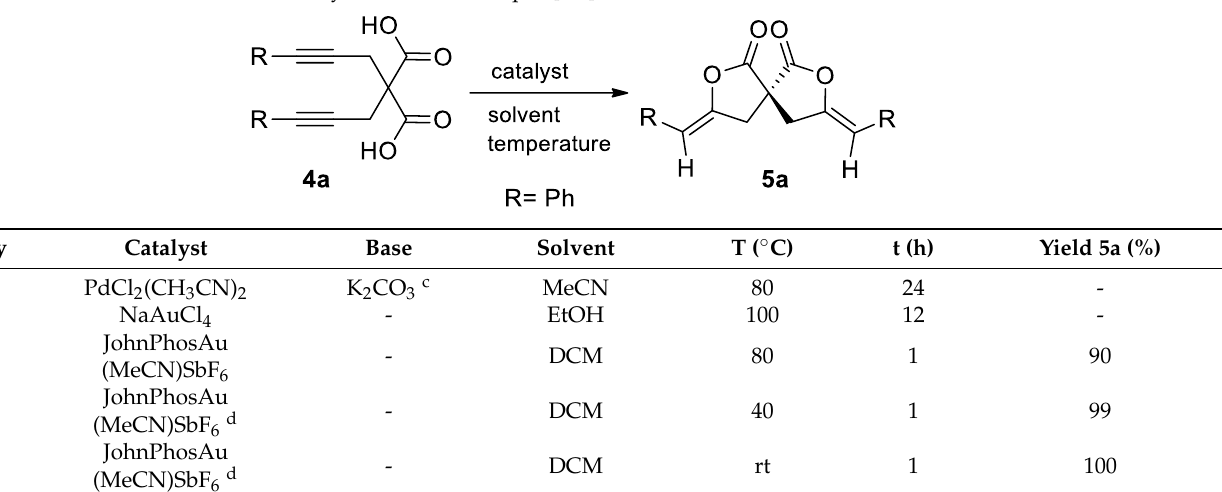
Table 1. Screening for the best catalyst and reaction conditions for the spirodilactonization to γ - arylmethylene-spirobislactones 5 : cyclization of 2,2-bis(3-phenylprop-2-yn-1-yl)malonic acid 4a to